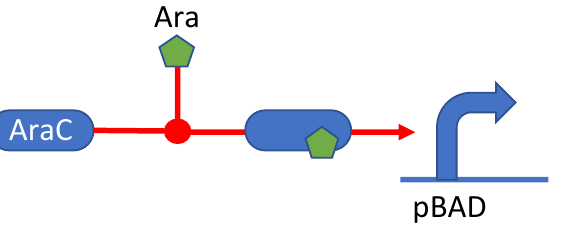
Figure 47: A coding sequence with three designated domains, an N-tag (blue), C-tag (yellow), and internal region (red).